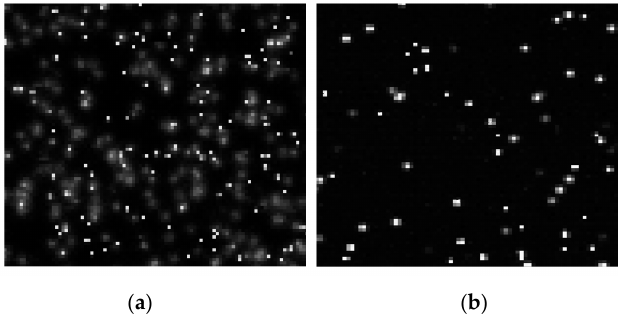
Figure 21. Mn (Fe-55) soft X-ray responses taken from an 8 um 3TPPD pixel image fabricated on 25 and 15 µm epitaxial silicon. Charge collection efficiency (CCE) performance for the thicker imager ( a ) is inferior compared to the thinner device ( b ).